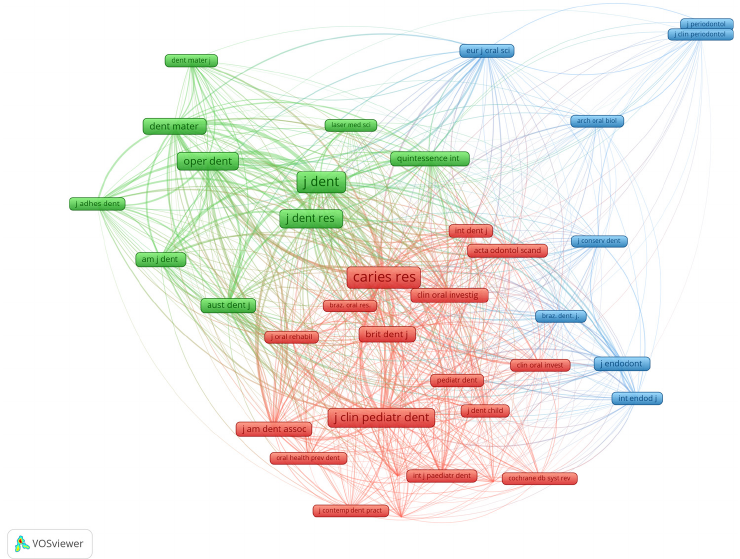
Figure 5. Network of co-citation of scientific journals. Source: own processing through VOSviewer.